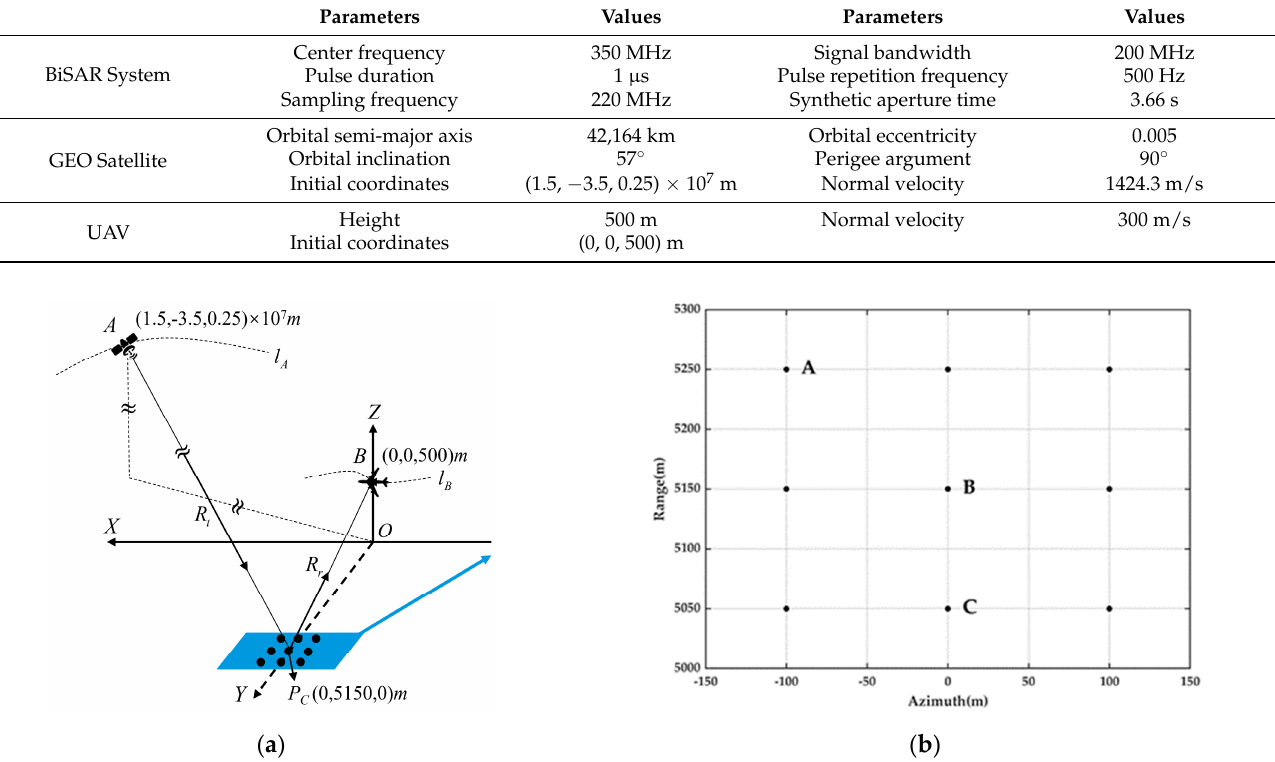
Table 2. Experimental parameters for the GEO-UAV VHF UWB BiSAR imaging.